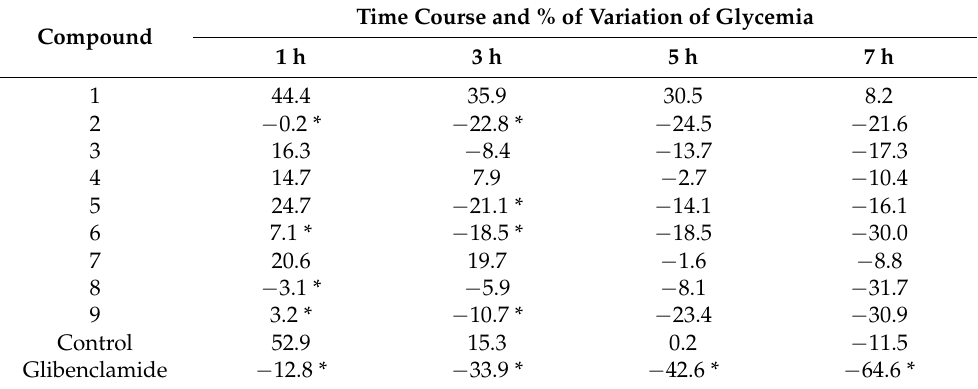
Table 1. Percentage of variation of blood glucose concentration during the in vivo acute antidiabetic assay performed with Compounds 1–9 .